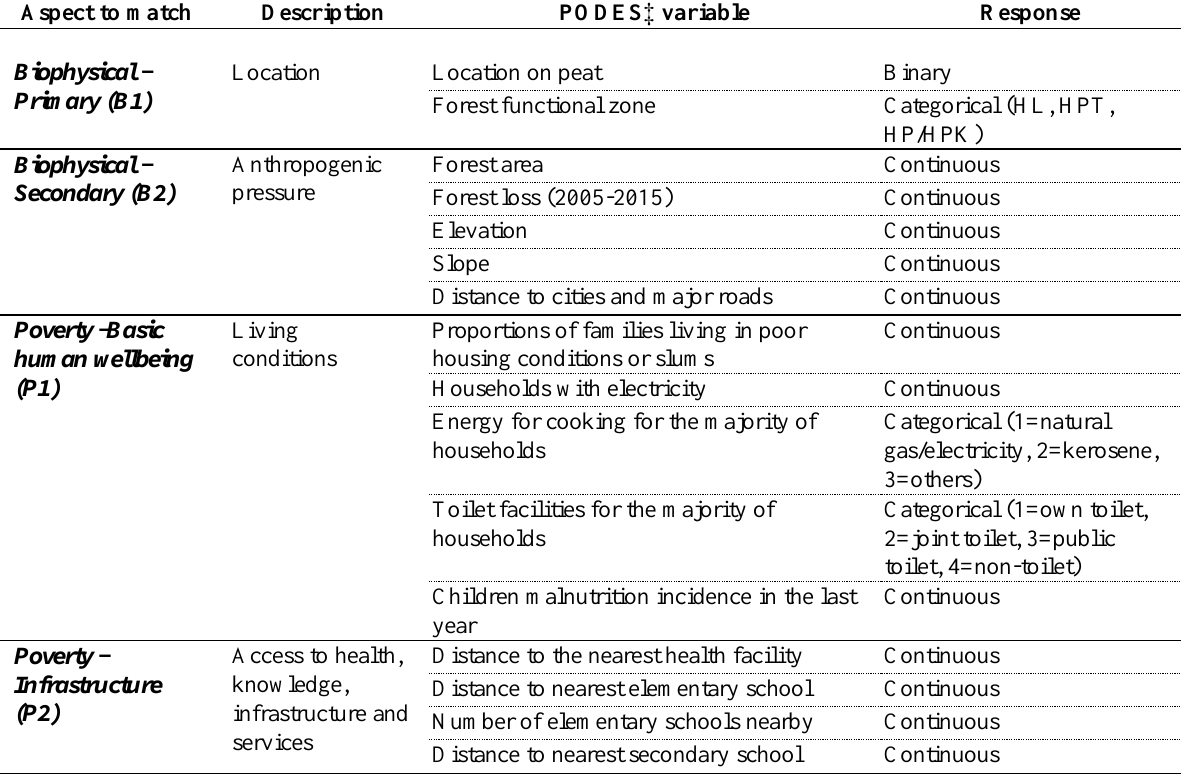
Table A1.2. List of baseline variables used in matching: (a) B1 (primary biophysical variables), (b) B2 (secondary biophysical variables), (c) P1 (basic human wellbeing variables), and (d) P2 (infrastructure